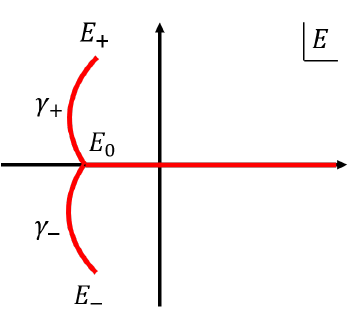
Figure 10. The support of “Y” shaped spectrum. The two complex conjugate ends are E ± and the joint point is E 0 . γ ± are two arcs connecting E 0 to E ±